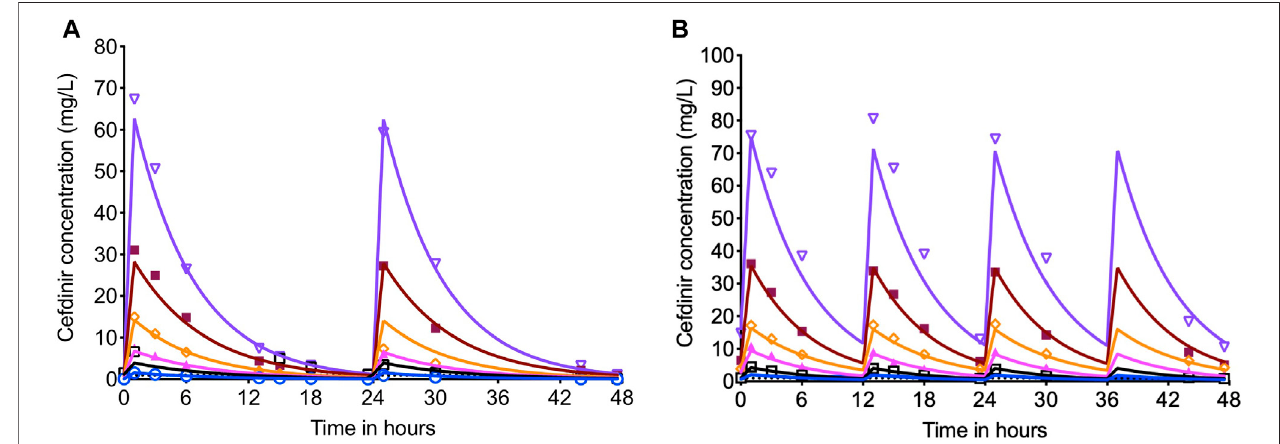
FIGURE 4 | Cefdinir concentration-time pro fi le in the HFS-TB. The cefdinir doses were selected to achieve different %T MIC . (A) The concentration time pro fi le of cefdinir with once daily or (B) twice daily dosing schedule. The solid lines represent modeled concentrations, and the symbols represent the observed concentrations in the HFS-TB.